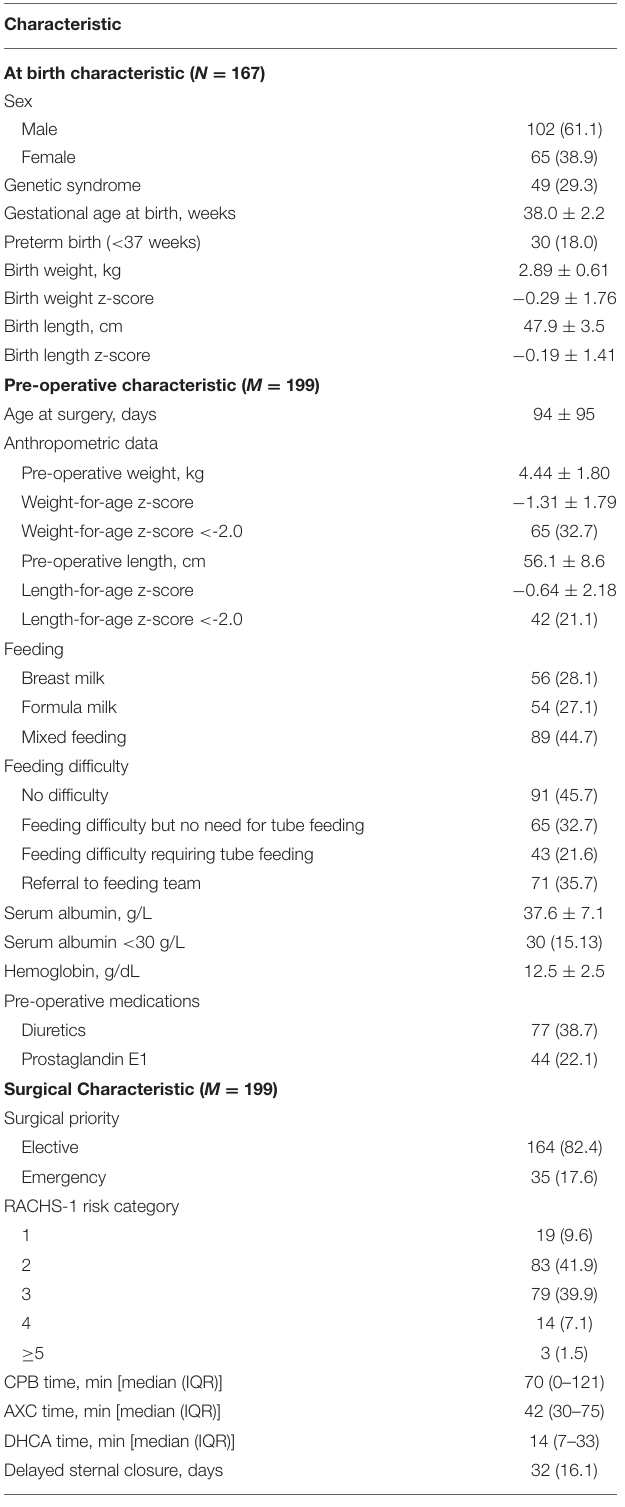
TABLE 1 | Demographic and clinical characteristics *